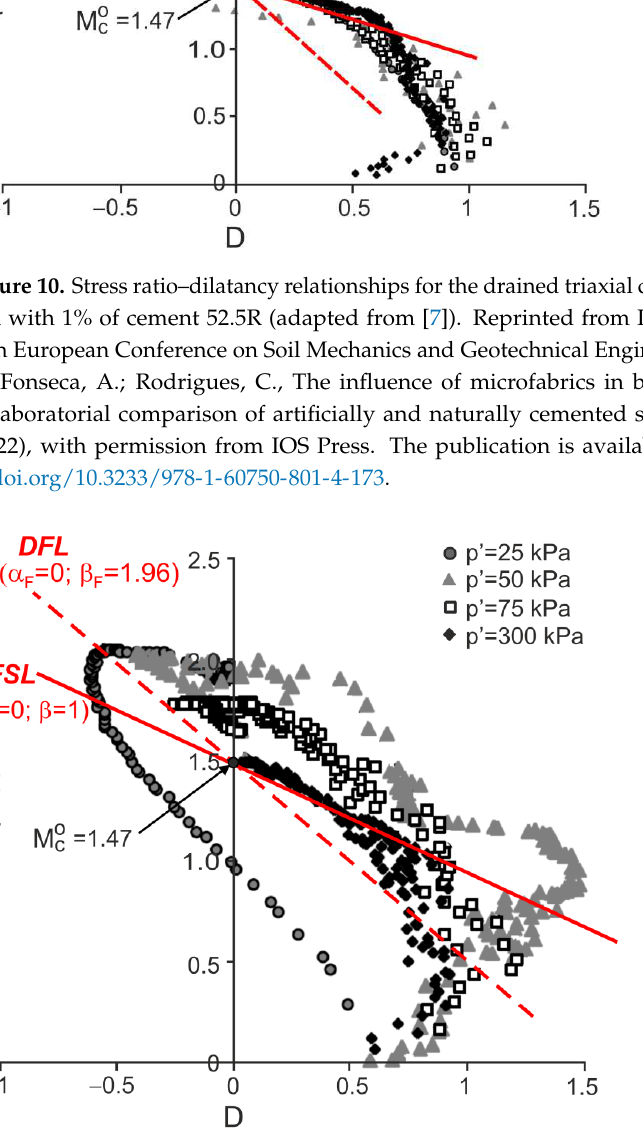
Figure 11. Stress ratio–dilatancy relationships for the drained triaxial compression of granitic residual soil with 2% of cement 32.5N (adapted from [7]). Reprinted from Publication Proceedings of